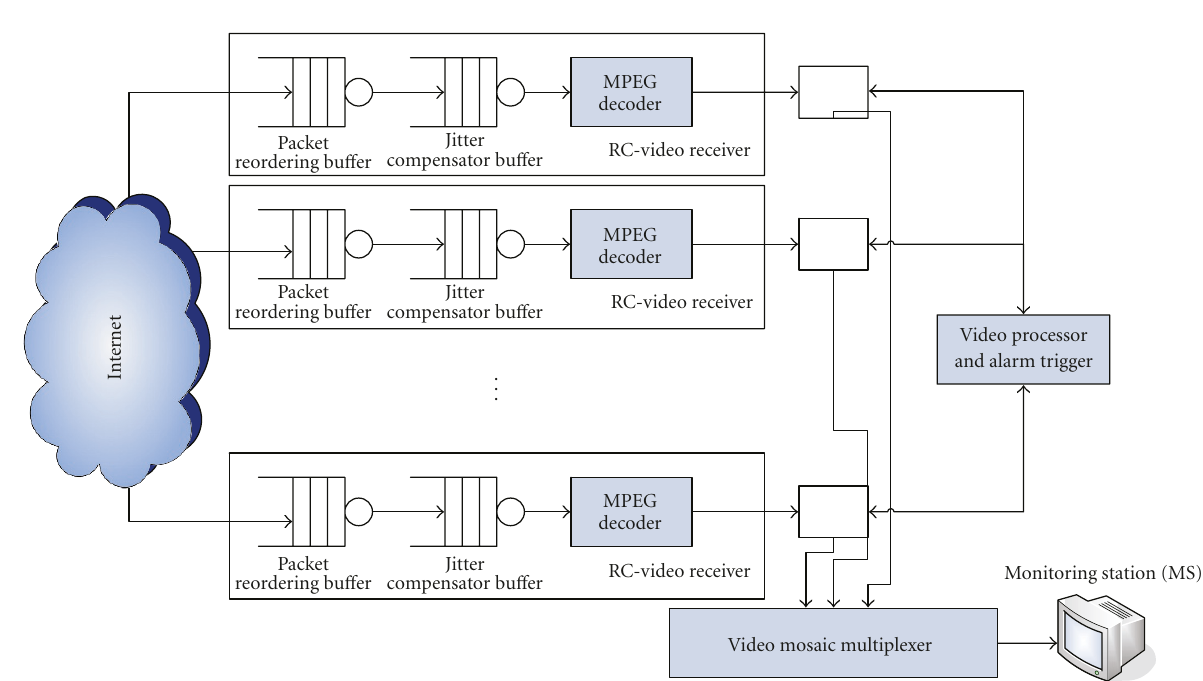
Figure 5: Rate-distortion curves.